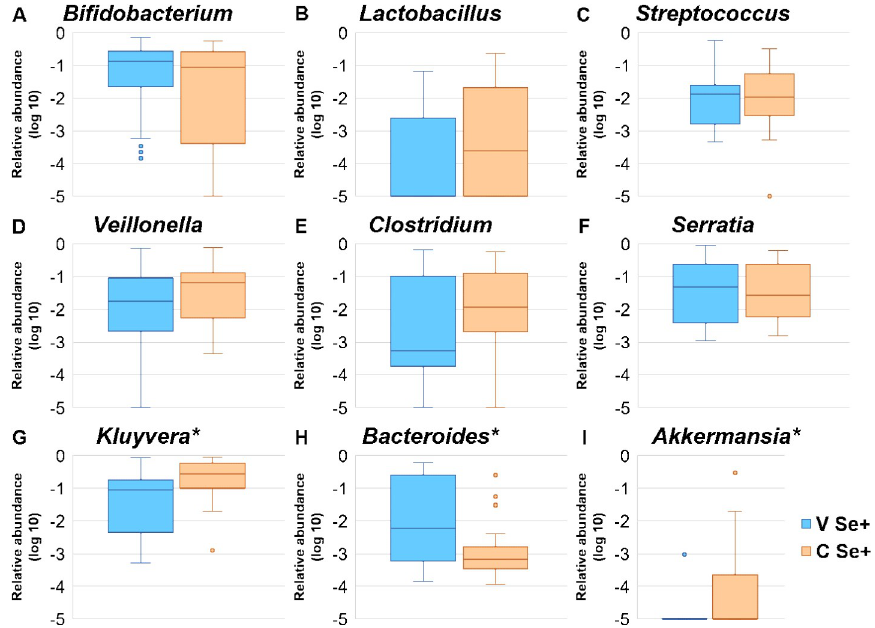
Fig 3. The average relative abundance of the most abundant bacterial genera in infants from secretor mothers, by birth mode. VSe+: Vaginally born (blue); CSe+: Cesarean born (yellow). The asterisks indicate statistical significance at p <